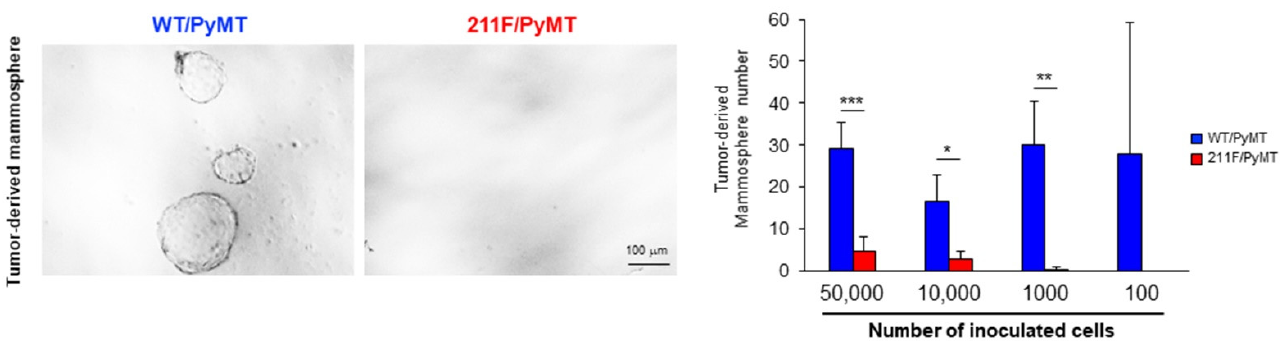
Table 1. Limiting dilution repopulation assay of WT/PyMT and 211F/PyMT cells. Confidence Intervals for Stem Cell Frequency Figure 3. Y211 phosphorylation is important for maintaining the stemness of cancer cells in vitro. ( A ), Left, representative plots of the ALDH + cell sub-population isolated from WT/PyMT and 211F/PyMT tumor tissues. Right, data from multiple tumors of each genotype were quantitated and plotted. The numbers of mice are indicated (n). ( B ), Bulk cell populations were independently iso- lated from a pair of WT/PyMT and 211F/PyMT tumor tissues, and their ALDH activities were com- pared either in the straight cell population (non-selected) or in the cell population after enrichment for epithelial cells by EpCAM pull-down (EpCAM − selected). The data derived from three inde- pendent pairs of tumor tissues were quantitated and plotted. Bar, standard deviation. *, p < 0.05, ***, p < 0.005 as determined by Student’s t − test. ( C) , Left, representative images of mammosphere for- mation by WT/PyMT and 211F/PyMT cells. Right, result quantification showed that mammosphere formation was compromised in 211F/PyMT. ***, p < 0.005 as determined by Student’s t − test.